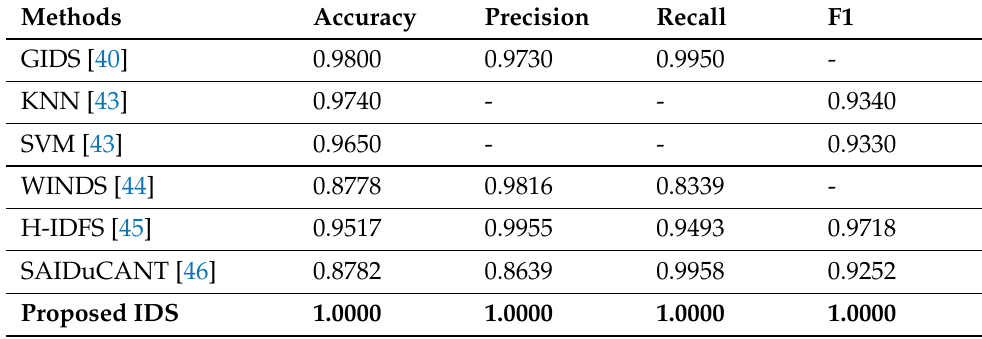
Table 13. Performance analysis against fuzzy attack for known IDS (car hacking dataset).